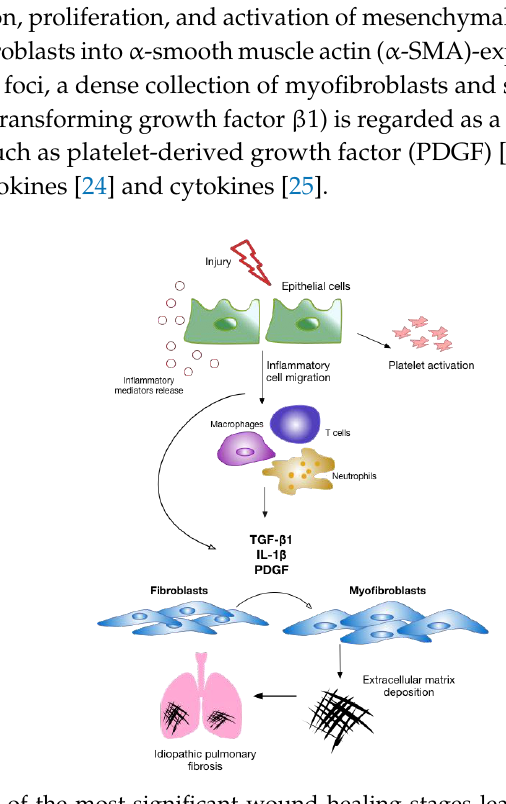
Figure 1. Overview of the most significant wound healing stages leading to the development of idiopathic pulmonary fibrosis (IPF). Epithelial cell injury leads to the secretion of inflammatory mediators and triggers platelet activation which results in enhanced vessel permeability for the recruitment of leukocytes. These inflammatory cells release pro-fibrotic cytokines such as TGF-β1 that mediate the activation and recruitment of fibroblasts as well as their differentiation into myofibroblasts and the subsequent release of extracellular matrix (ECM) components to promote wound healing. In IPF, an aberrant wound repair response leads to the irreversible formation of excessive scar tissue in the lungs. At the present time, the drivers of the aberrant wound healing process leading to fibrosis are unknown. However, certain cells types such as alveolar epithelial cells and fibroblasts, as well as a dysregulated coagulation and inflammatory response have been implicated in disease initiation and progression [1,26–28].